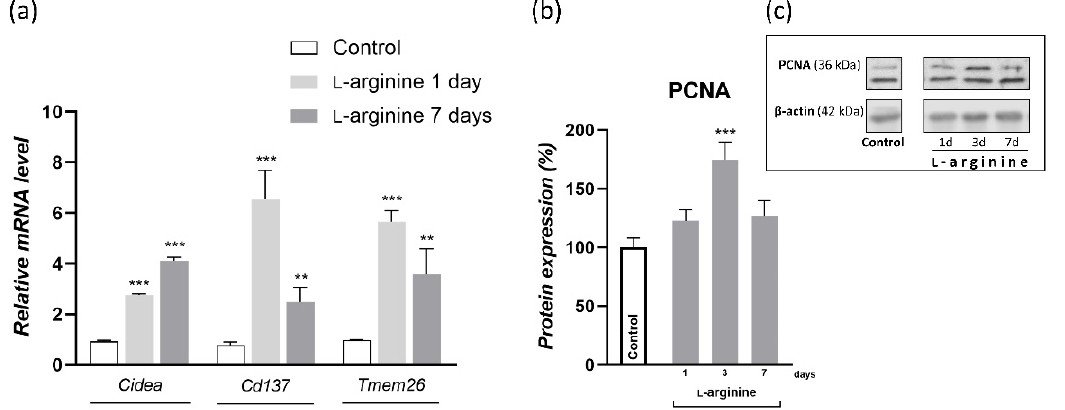
Figure 7. The L -arginine treatment induces gene expression of thermogenic beige adipocyte markers cell death-inducing DFFA like effector A ( Cidea ), Tmem26 , and Cd137 and protein levels of proliferation marker proliferating cell nuclear antigen (PCNA) in rat retroperitoneal white adipose tissue (rpWAT). Adipose tissue gene expression (mean ± SEM of normalized ratios with 18S) of Cidea , Tmem26 , and Cd137 in rats treated with 2.25% L -arginine · HCl for 1 and 7 days is upregulated by L -arginine, as compared to the control group ( a ). Also, PCNA protein levels after 1, 3, and 7 days of L -arginine treatment were analyzed in rpWAT by Western blot, as presented in the Material and Methods section. The protein content is expressed relative to control rats (100%) ( b ), and the respective bands are presented ( c ). Data represent the mean ± SEM. * Compared to control, ** p < 0.01, *** p < 0.001. Experiments were repeated in triplicate.